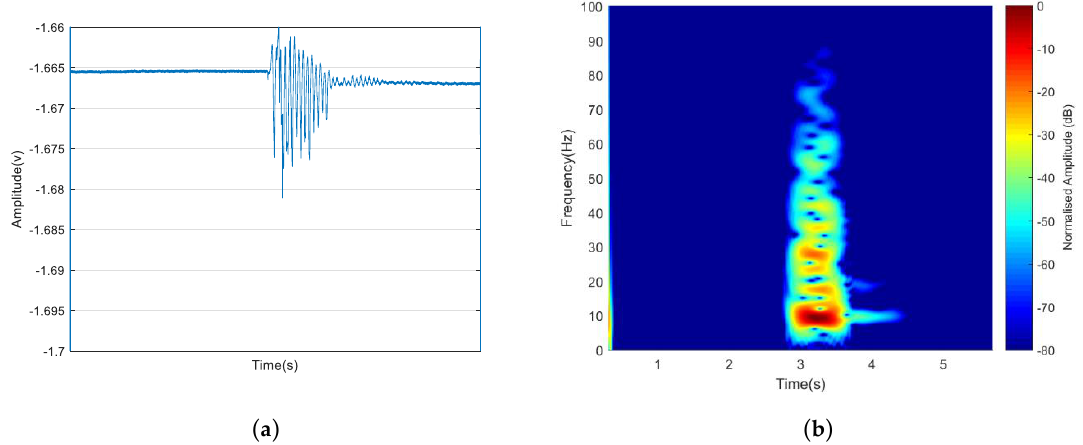
Figure 15. ( a ) Received signal in time domain at the output of ADC, and ( b ) its time–frequency representation of the sampled signal (1–6 s) denoted as target signature.